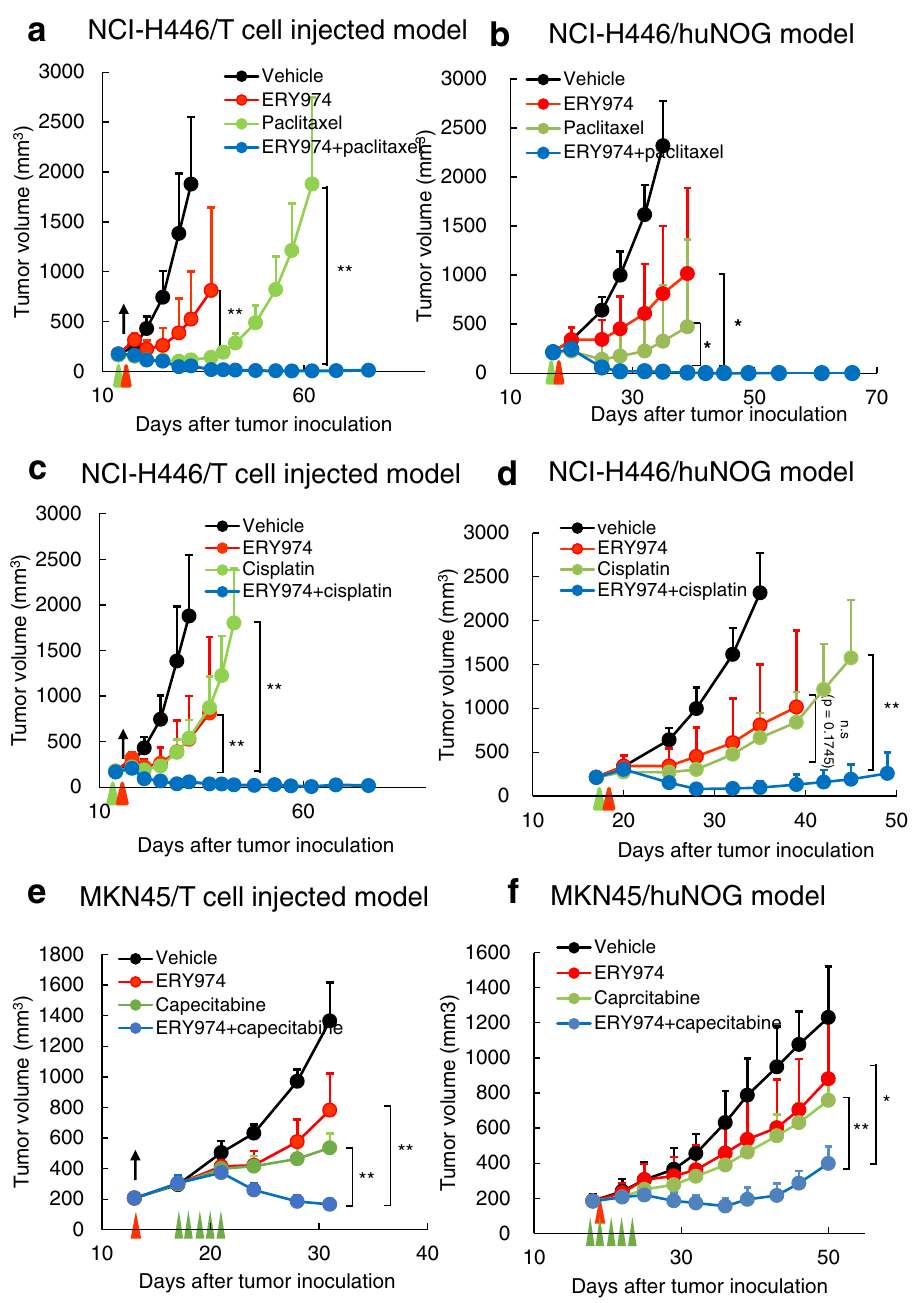
Fig. 2 | Combination of ERY974 and chemotherapy shows more ef fi cacy than ERY974 or chemotherapy alone in both huNOG and T cell-injected models. a , b ERY974(1and5mg/kgin a and b ,respectively)+paclitaxel(20mg/kg)ef fi cacy in NCI-H446 xenograft tumours in the T cell-injected ( a ) and huNOG ( b ) models ( n =5). During study, one mouse in the ERY974+paclitaxel group in ( b ) was sacri fi ced due to body weight loss on day 35. c , d ERY974 (1 and 5mg/kg in c and d , respectively)+cisplatin (7.5mg/kg) ef fi cacy in NCI-H446 xenograft tumours in theTcell-injected( c )andhuNOG( d )models( n =5).Duringstudy,onemouseinthe ERY974+cisplatin group in ( c ) was sacri fi ced due to body weight loss on day 53. e, f ERY974 (5mg/kg)+capecitabine (431 and 359mg/kg in e and f , respectively) ef fi cacy in MKN45 xenograft tumours in the T cell-injected ( e ) and huNOG ( f ) models. Red and green arrows indicate the timing of ERY974 and chemotherapy